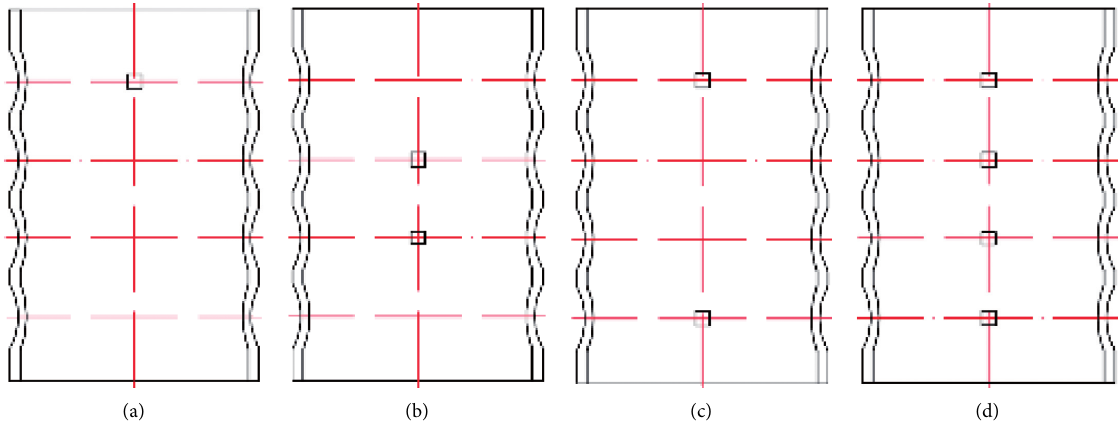
Figure 2: Schematic diagram of the central detonation point structure.